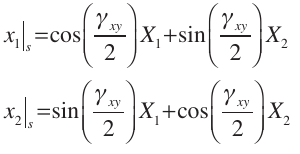
The superscript k represents the corner number. Through substitution of Eqs. (1) and (2), it is possible to obtain the and X into Eqs. (1) and (2). current positions of all RVE corners with respect to the input 1 2 state of deformation (defi ned by nominal strains ε γ ) as well as the original positions ( X xy